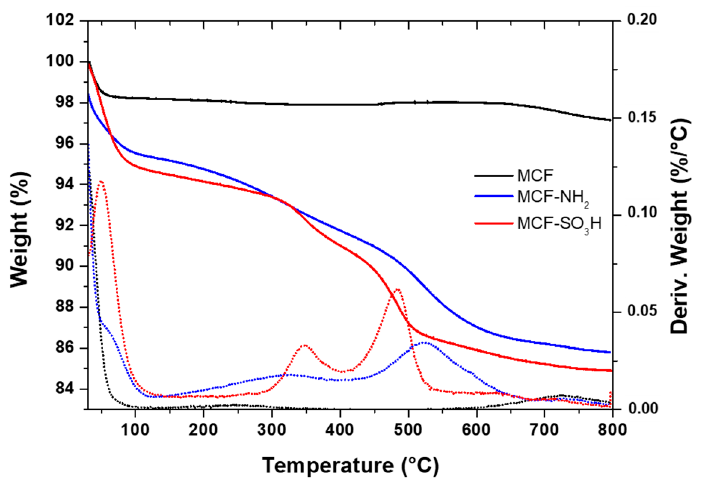
Figure 7. Thermogram of silica MCF before and after modification with APTES (MCF-NH 2 ) and MPTMS (MCF-SO 3 H).